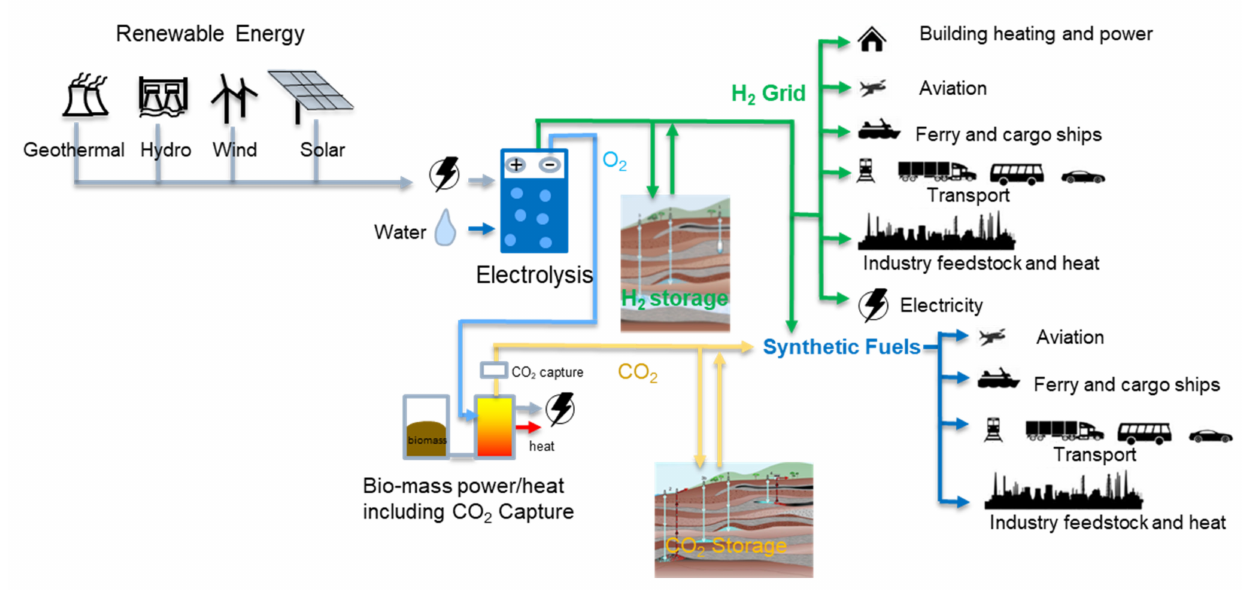
Figure 2. Generation, storage, and usage of hydrogen from renewable energy sources.